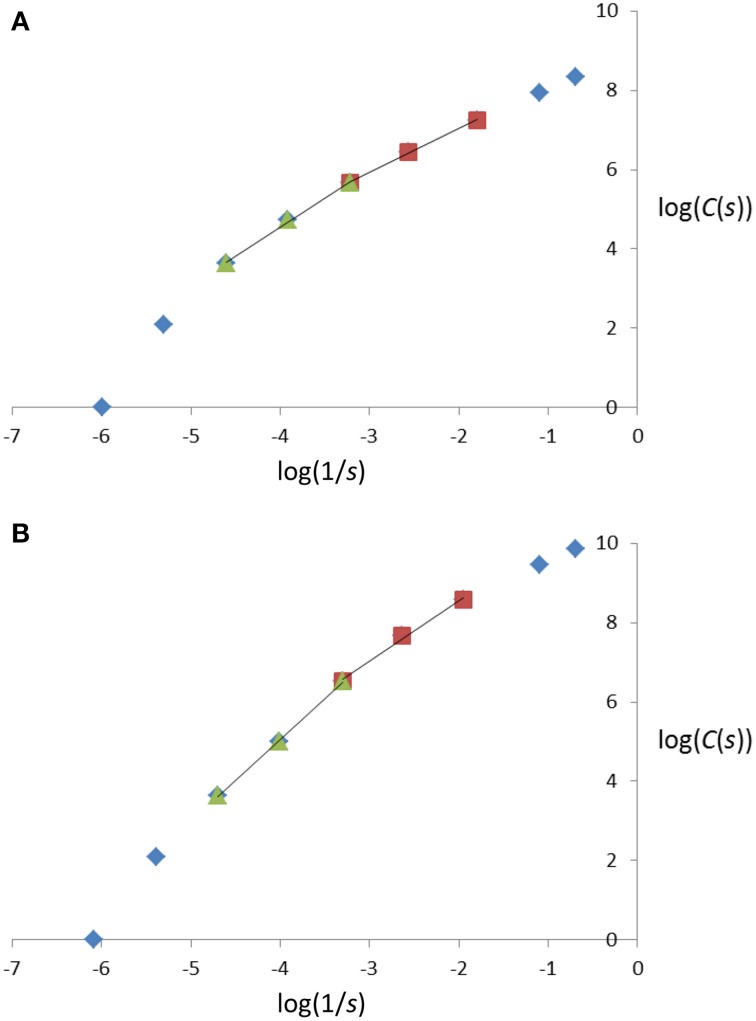
Plot of log(C(s)) against log(1/s), with s representing the cube sidelengths used in the cube-counting procedure of fractal dimension estimation, and C(s), the number of cubes with sidelength s, for the two miniature coniferous trees, (A) Picea abies Tompa and (B) Microbiota decussata Gold Spot, in Figures 1A, 3A and 1B, 3B, respectively. See text for details about the estimation procedure.